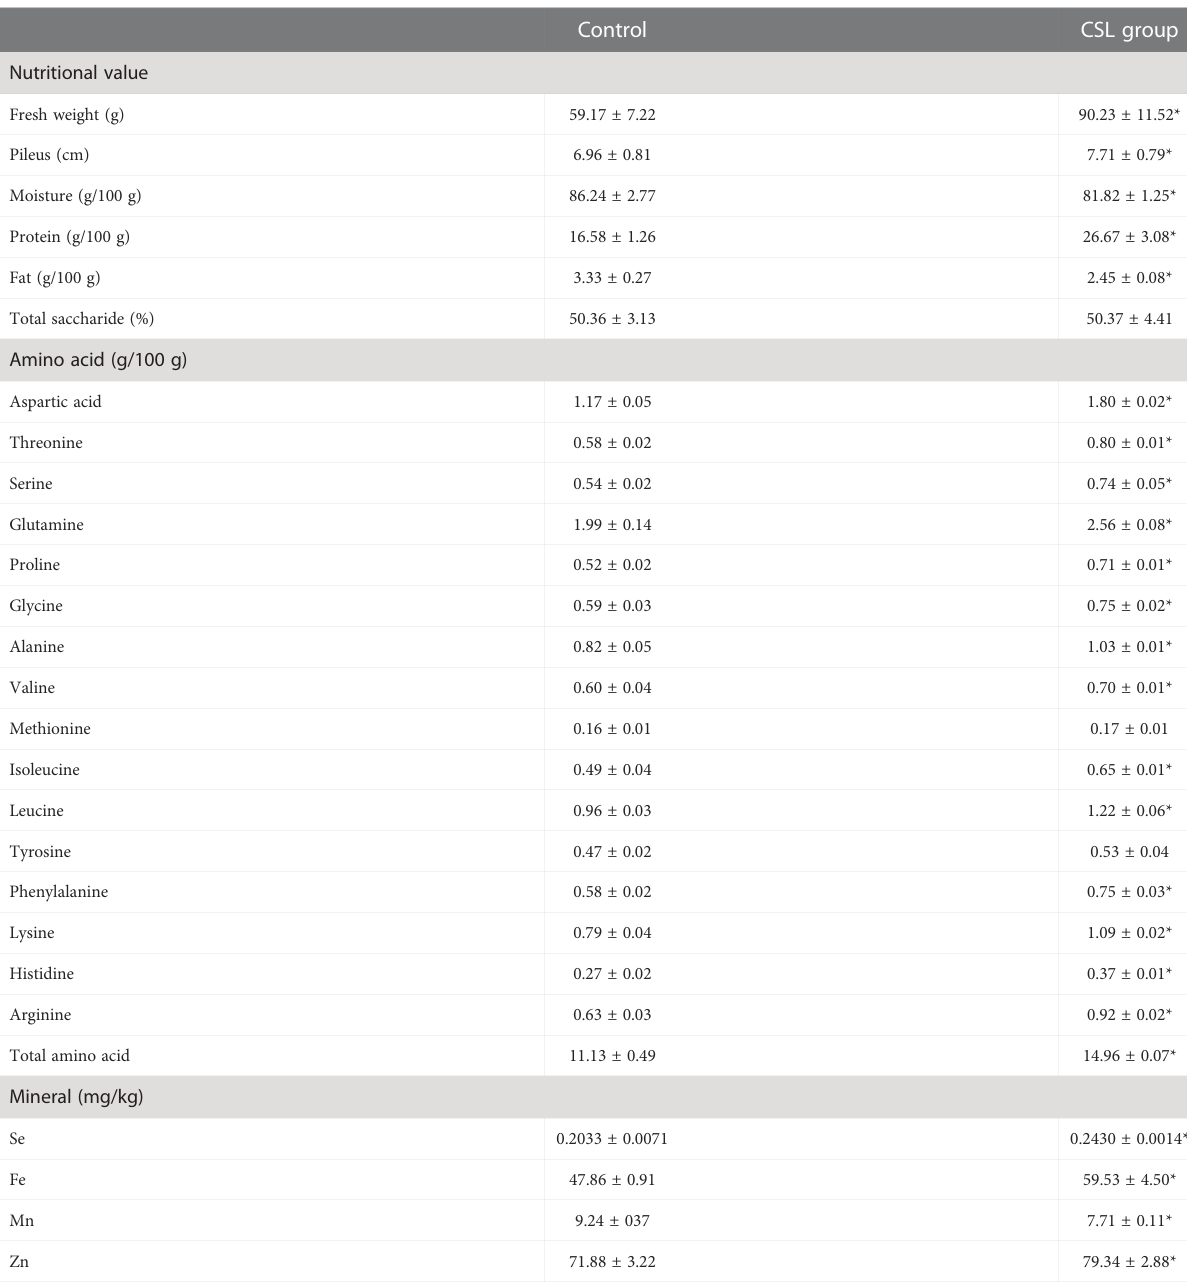
TABLE 1 Nutritional value, amino acid content and elemental concentrations of P. ostreatus (mean ±